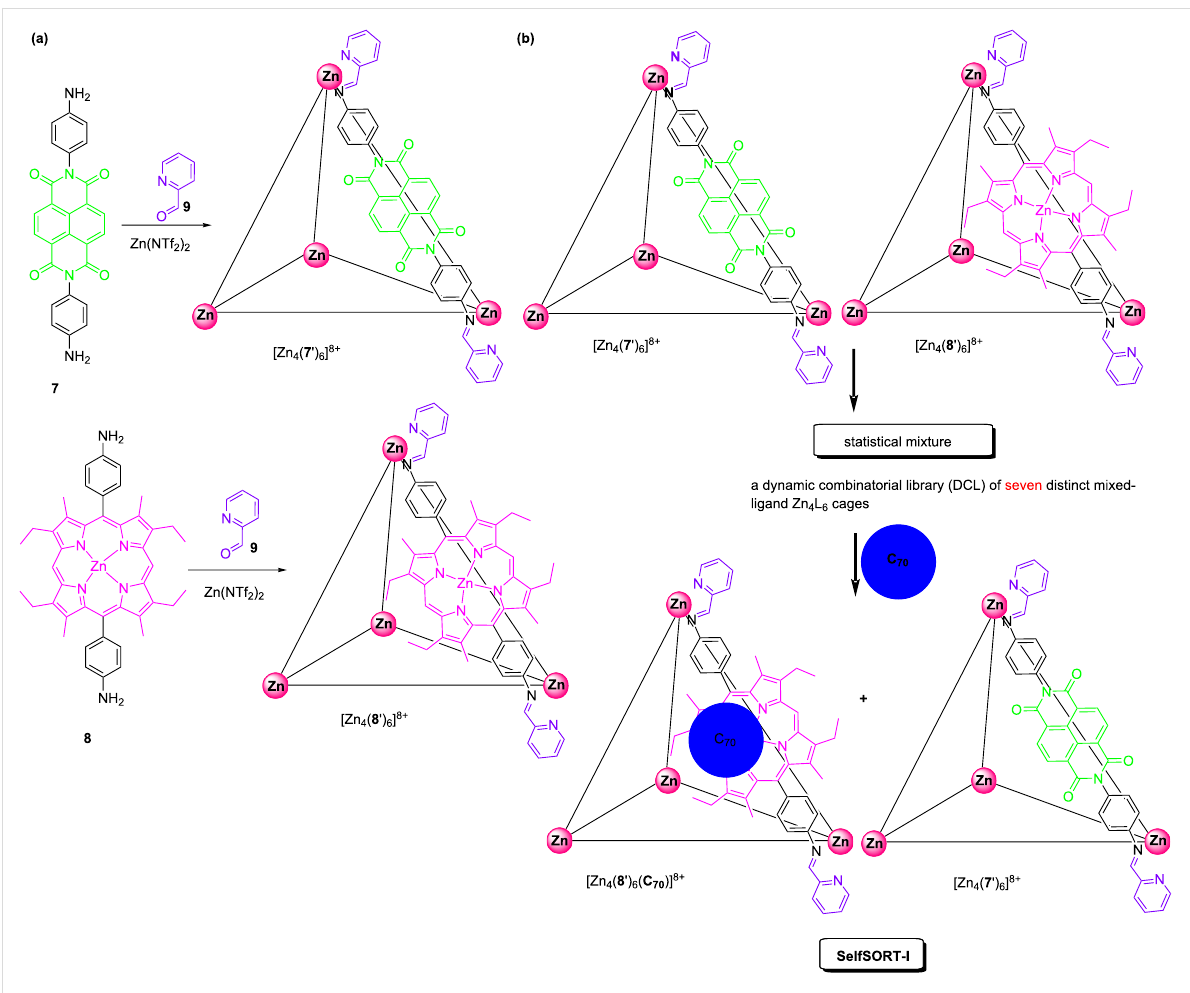
Figure 5: (a) Two new Zn 4 L 6 -type cages. (b) The encapsulation of C 70 induced distinct reconstitutions within a dynamic library of mixed ligand Zn 4 L 6